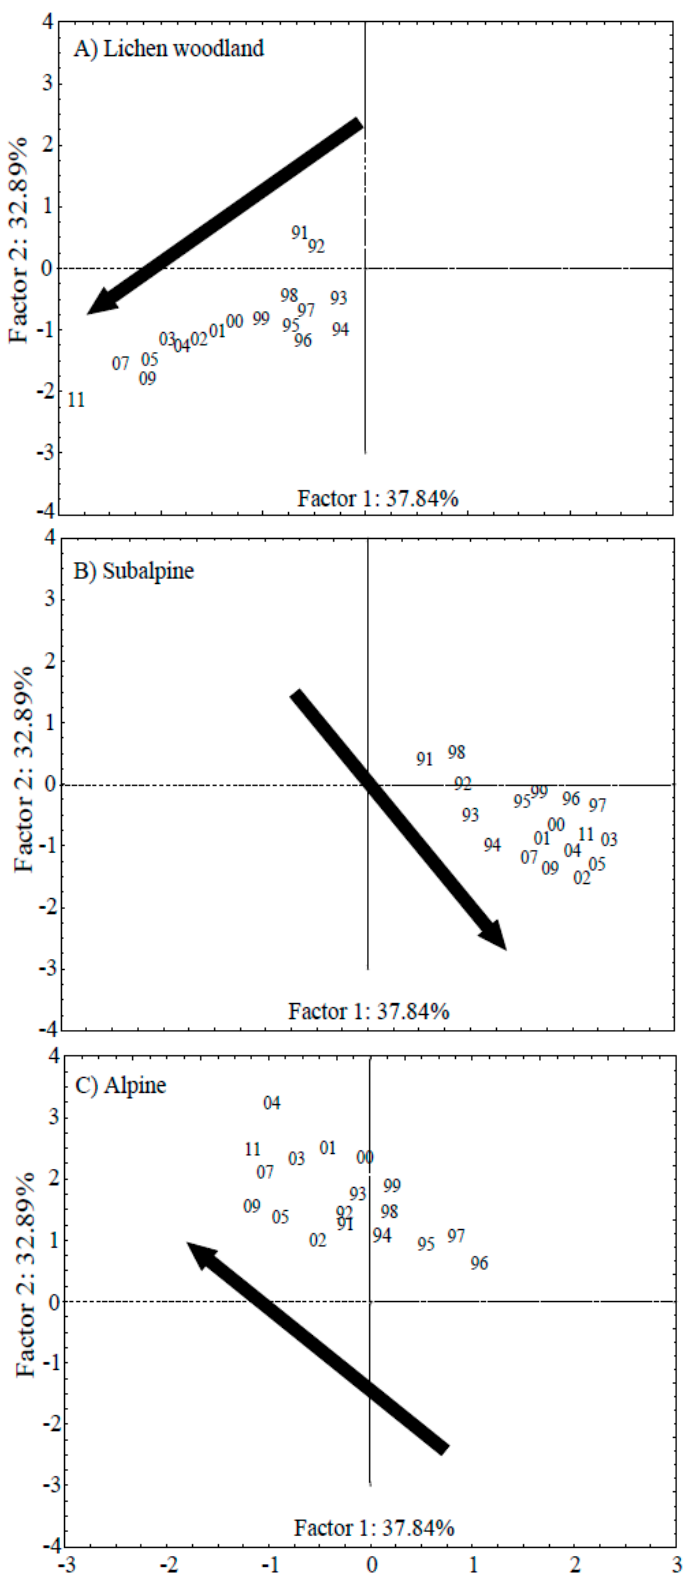
Figure 5. Principal component analysis (PCA) of the functional groups among the postfire sites. Only factor cases per experimental site are shown to facilitate reading. Variables are shown at Figure 4. The arrows represent the successional pathways for each site.